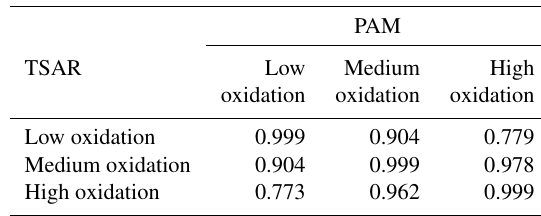
Table 2. Dot product between the organic spectra of PAM- and TSAR-generated